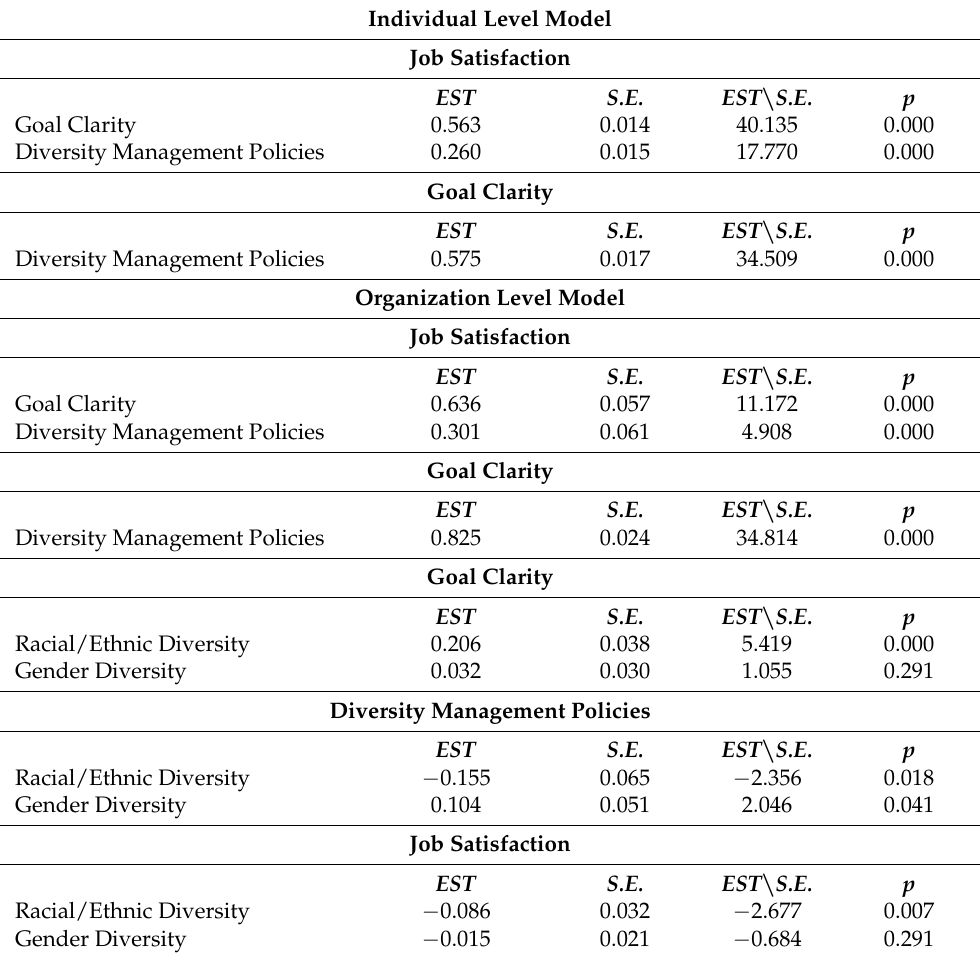
Table 2. Standardized parameter